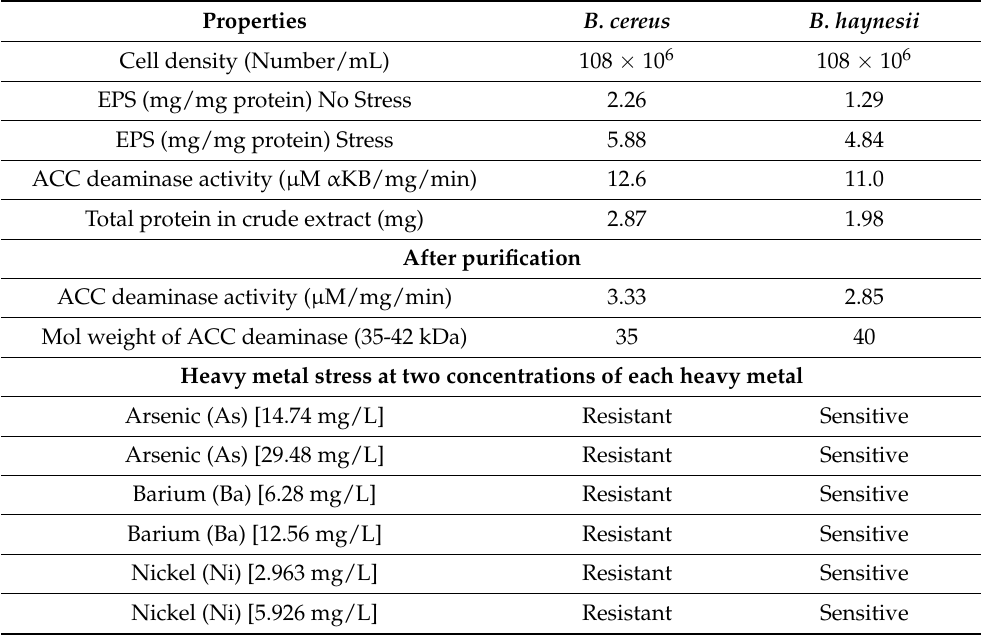
Table 2. Performance of bacterial isolates under in vitro drought and heavy metal